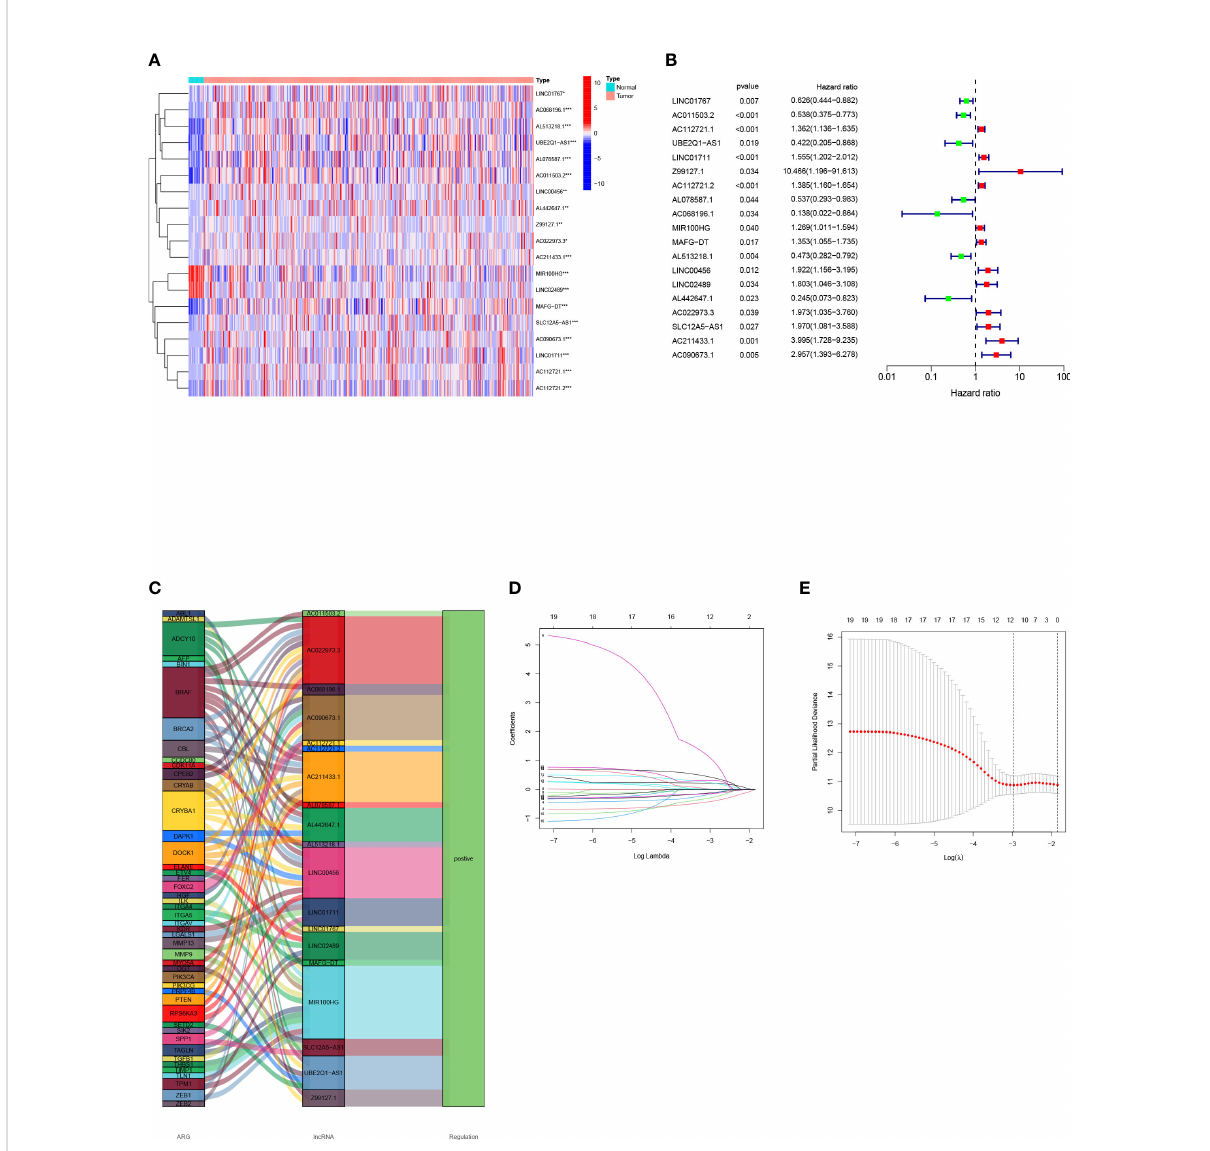
FIGURE 2 Construction of a bladder cancer arlncRNAs risk model: (A) Volcano plot of 19 prognosis-related arlncRNAs expressed in normal tissues and tumors; (B) Forest map of prognostic arlncRNAs extracted by uni-COX regression; (C) Sankey diagram of ARGs-arlncRNAs correlation; (D) Screening of prognostic arlncRNAs via cross validation; (E) Curve of error rate 10-fold